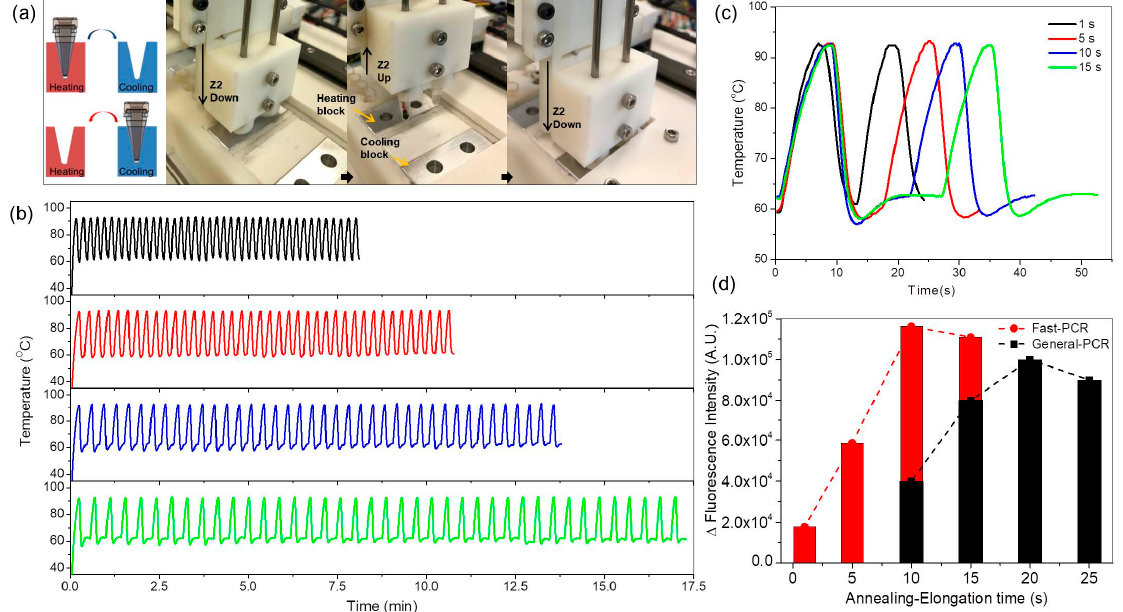
Figure 4. ( a ) Schematic image and photographs of each step to generate rapid thermal ramp cycles by heating exchangers transporting conical PCR microtubes between heating and cooling blocks. ( b ) Temperatures during thermocycling for fast PCR amplification when the annealing/elongation time was 1 s (black line), 5 s (red line), 10 s (blue line), and 15 s (green line), ( c ) temperatures of two thermal cycles depending on annealing/elongation time for enlargement. ( d ) Optimization of annealing/elongation time for fast PCR (red bar) and general PCR (black